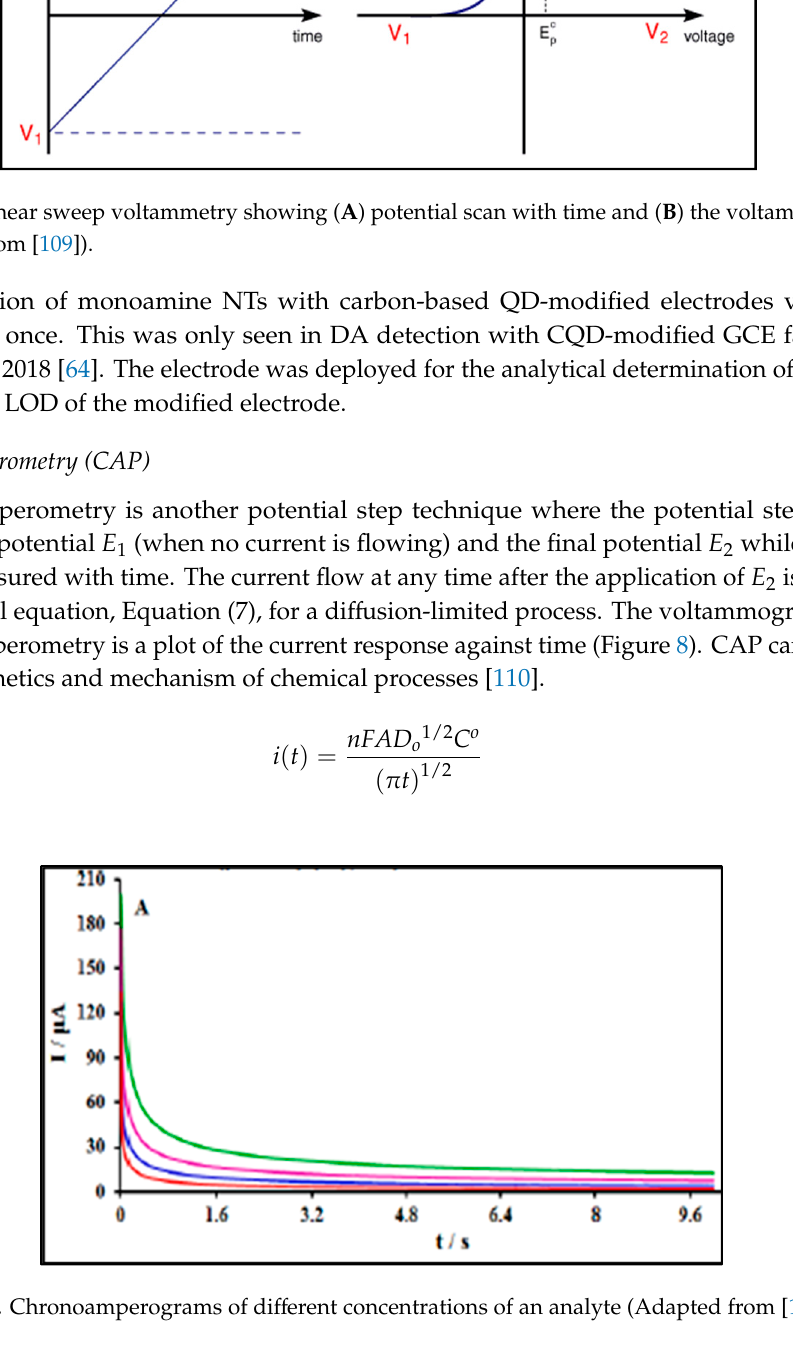
Figure 8. Chronoamperograms of different concentrations of an analyte (Adapted from [111]). Chronoamperometry was used for the analytical determination of EP using the GQD-modified CPE prepared by Tashkhourian et al. [86] with very low LOD (0.3 nM) reported for the electrode. This was the only time CAP was applied for analytical determination of monoamines with a carbon- based QD-modified electrode. With the aid of Cottrell’s equation Equation (7), Jahani [111] calculated the diffusion coefficient, D o as 1.6 × 10 − 6 cm 2 /s from the experimental value of the current, i and square root of time, t obtained with the application of the fabricated GQDs/IL/CPE for NE detection.